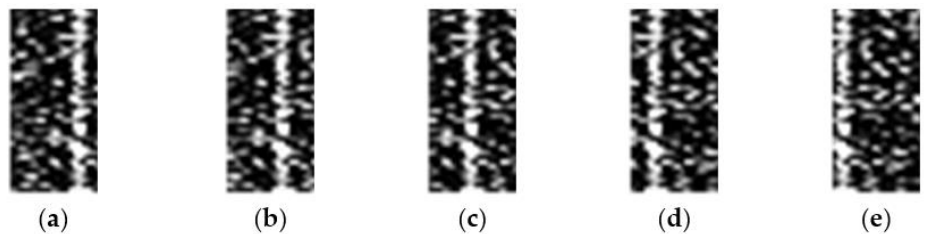
Figure 12. Partial 20 × 20 sample graph without target under the condition of 0 dB SNR, and the units are ( a ) 1000th, ( b ) 2000th, ( c ) 3000th, ( d ) 4500th, and ( e ) 6000th.